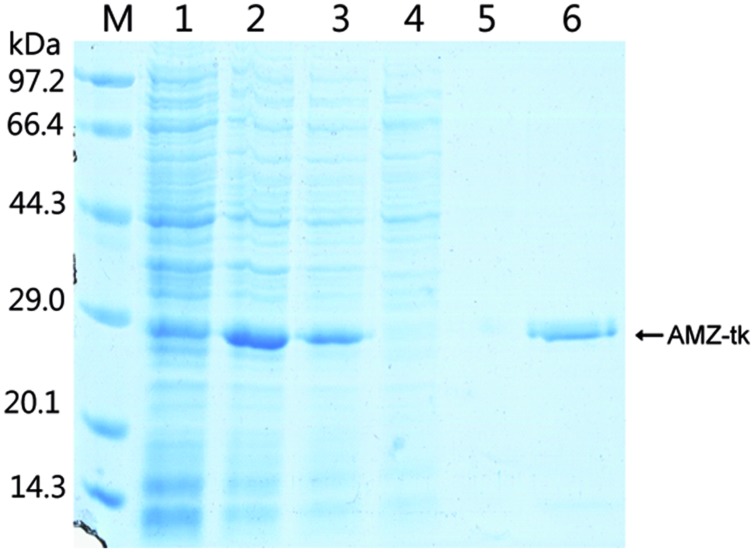
Expression and purification of AMZ-tk from Escherichia coli. Lane M, protein marker; the molecular mass standards are indicated at the left. Lane 1, crude protein extract from non-induced cells; Lane 2, crude protein extract from IPTG-induced cells; Lane 3, soluble extract from IPTG-induced cells after heating at 70°C for 1 h; Lane 4, unbound proteins eluted from the Ni-NTA column; Lane 5, proteins eluted with 20 mM imidazole; Lane 6, proteins eluted with 300 mM imidazole.